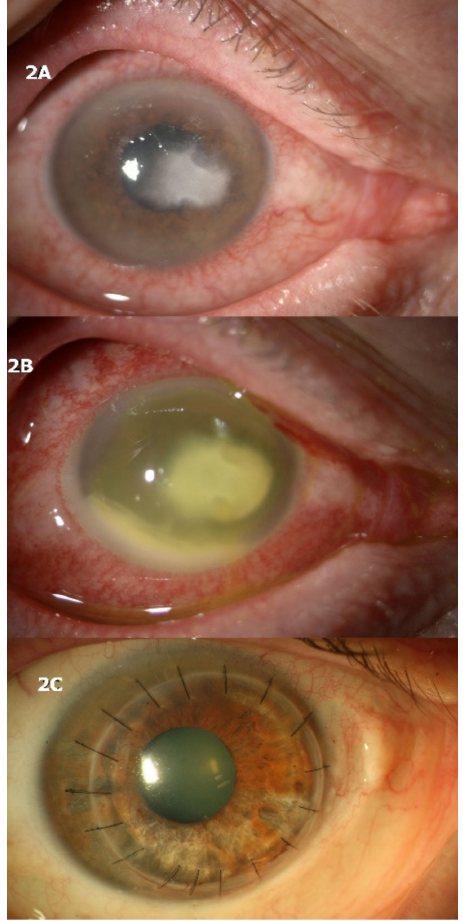
Figure 2. The second patient, also affected by contact lens-related infectious keratitis, was diagnosed with filamentous fungi infection. ( A ) When steroid therapy was discontinued abruptly, severe worsening of clinical signs ( B ) required immediate therapeutic penetrating keratoplasty ( C